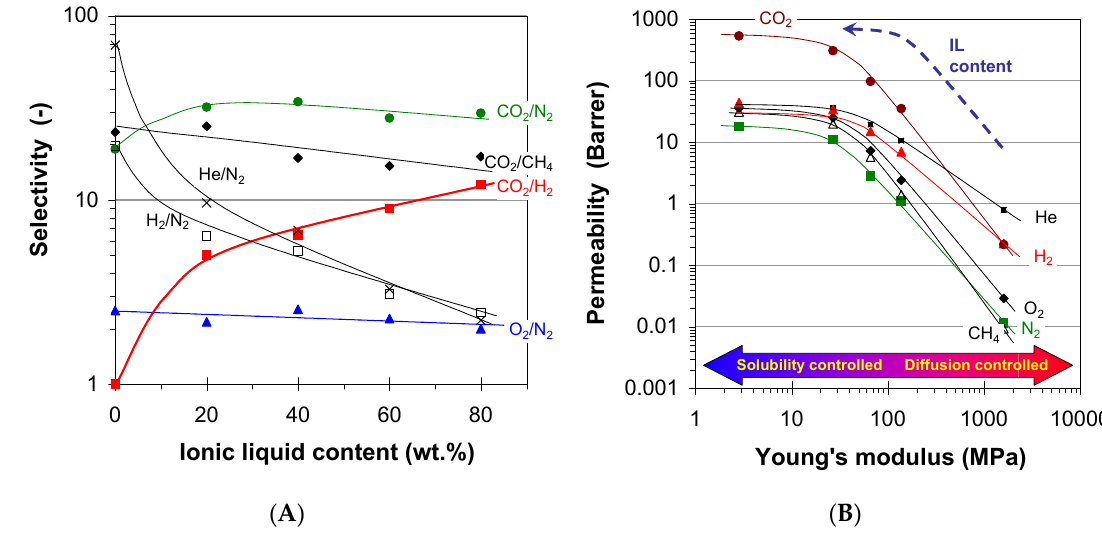
Figure 9. ( A ) Correlation of the selectivity and the ionic liquid content and ( B ) correlation of the permeability and Young’s modulus for p(VDF-HFP)/[EMIM][Tf 2 N] membranes with IL content ranging from 0% to 80%. 1 Barrer = 10 − 10 cm 3 STP cm cm − 2 s − 1 cmHg − 1 = 3.348 × 10 − 16 mol m m − 2 s − 1 Pa − 1 . Reprinted from [256] . Copyright (2012), with permission from Elsevier.